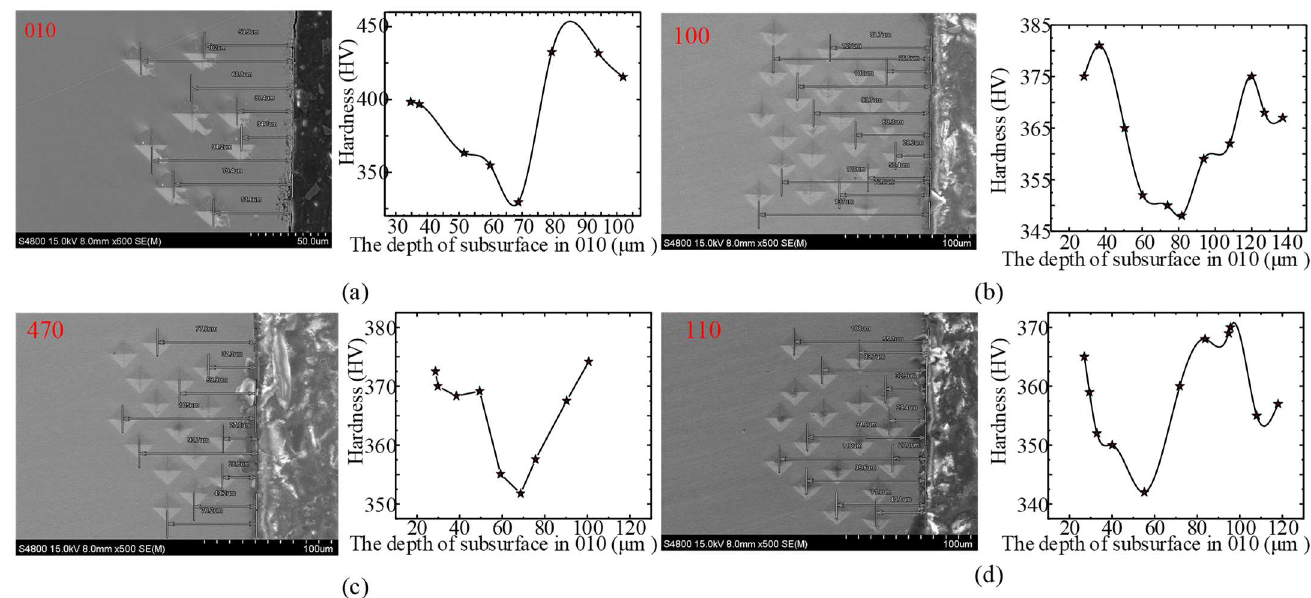
Figure 9. The depth of measurement points and the relationship between hardness and the depth of subsurface in ( a ) 010, ( b ) 100, ( c ) 470, and ( d ) 110. subsurface in ( a ) 010, ( b ) 100, ( c ) 470, and ( d )